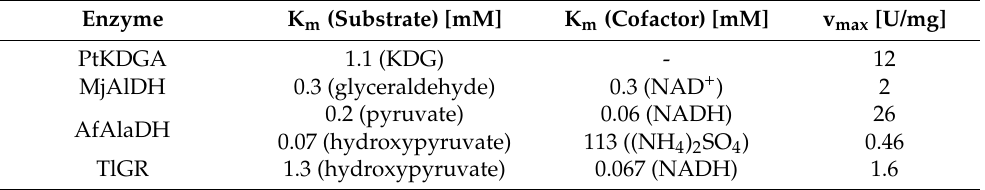
Table 1. Overview of the kinetic data of the used enzymes. Data are taken from the literature and were supplemented with own measurements